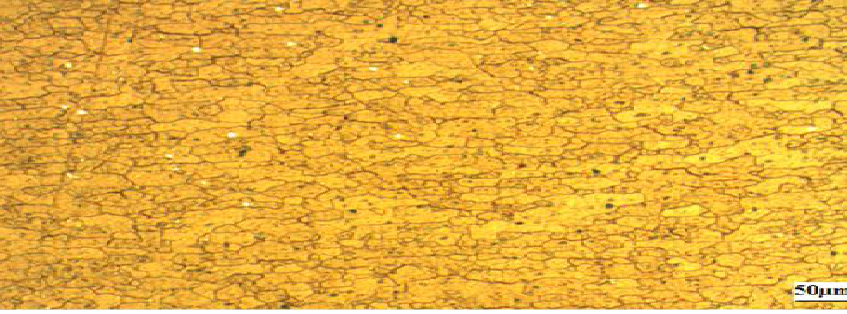
Figure 5. Microstructure of the 6061-T6 aluminum alloy.